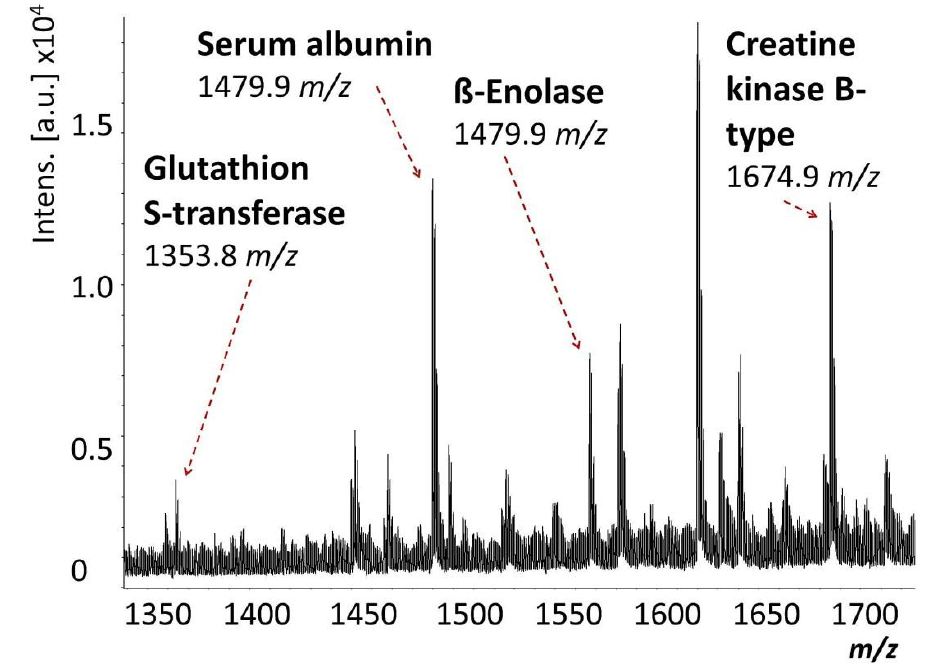
Figure 6. Exemplary solid-phase extraction matrix-assisted laser desorption time-of-flight (MB) MS spectrum displaying selected tissue candidate reporter peptide peaks.